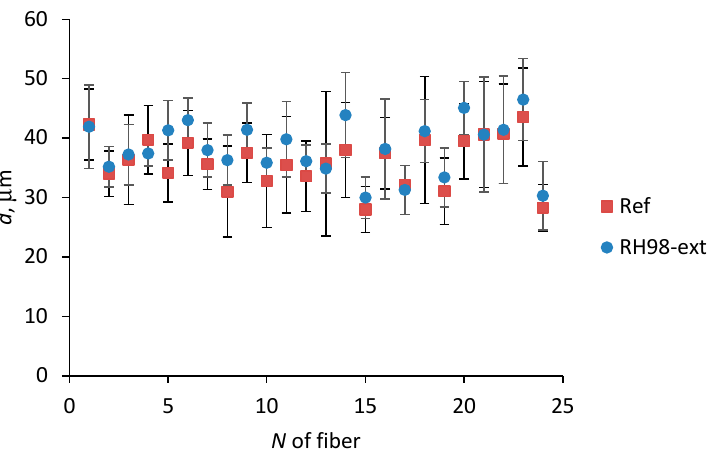
Figure 4. Diameter of fibers in the reference state and after exposure under an RH of 98%.